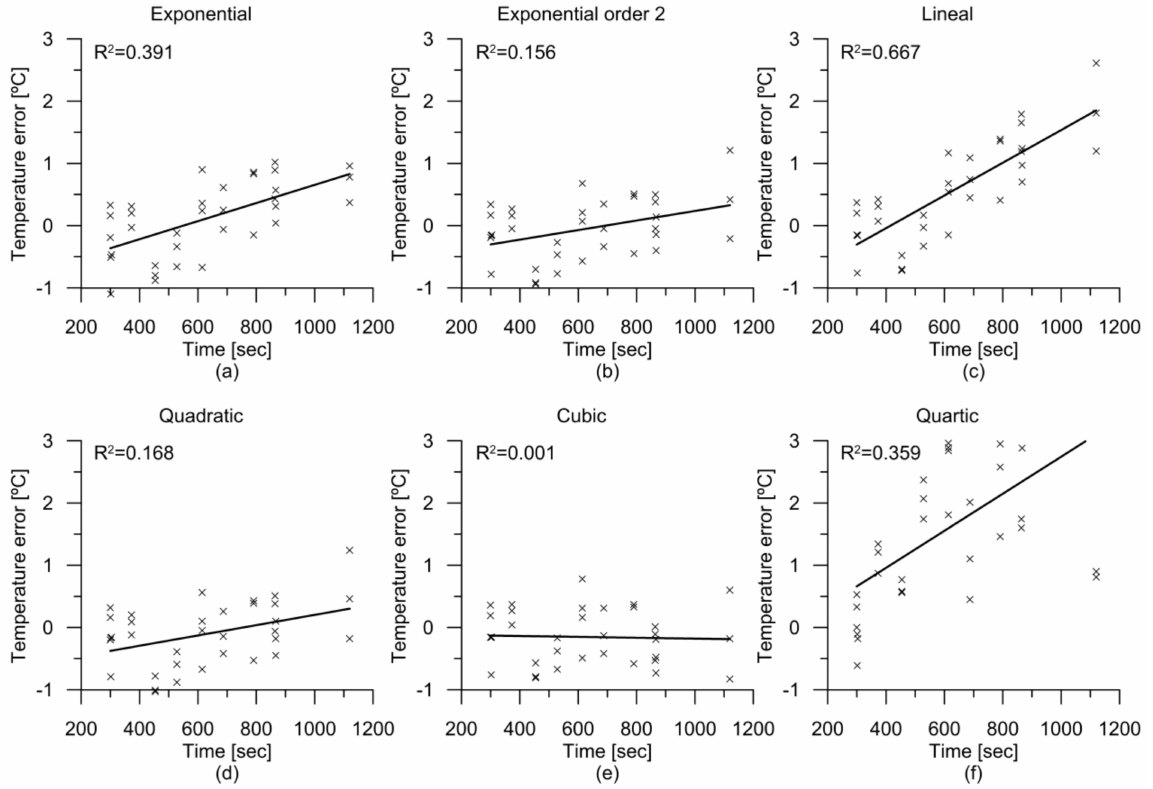
Figure 8. Relationship for each DCM between temperature error and flight duration for the 16:30 p.m. mission. DCM: ( a ) exponential, ( b ) exponential order 2, ( c ) lineal, ( d ) quadratic, ( e ) cubic, ( f )